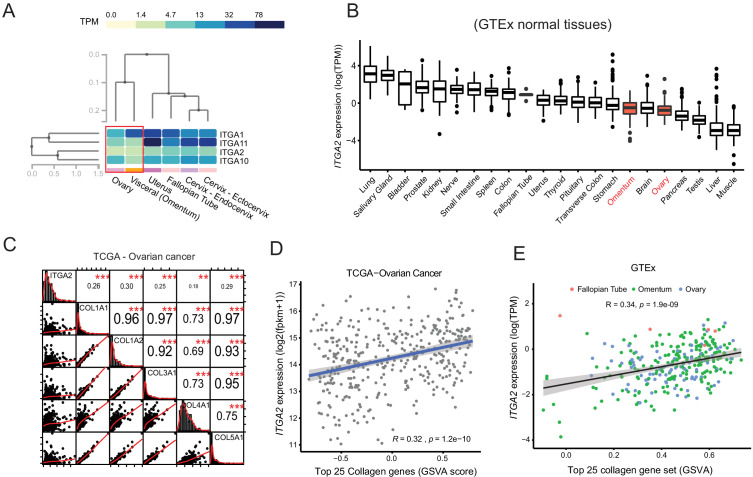
ITGA2 expression correlates with collagen expression in TCGA and GTEx dataset.(A) Unsupervised hierarchical cluster analysis and heat map visualization of genes encoding collagen-binding integrins (α1, α2, α10, and α11) from gynecologic tissues data obtaining from GTEx database. (B) ITGA2 expression (log(TPM)) in 22 non-diseased tissues from (GTEx dataset). (C) Spearman’s correlation matrix of ITGA2 and selected collagens in the TCGA-ovarian cancer RNA-seq dataset. The top of the diagonal represents pairwise Spearman’s correlation coefficients and significance level (*p<0.05, **p<0.01, ***p<0.001). On the bottom of the diagonal: bivariate scatter plots with a fitted line are displayed. (D) Correlation between a set of top 25 expressed collagen genes (GSVA) and ITGA2 in TCGA and in (E) GTEx RNA-seq dataset.